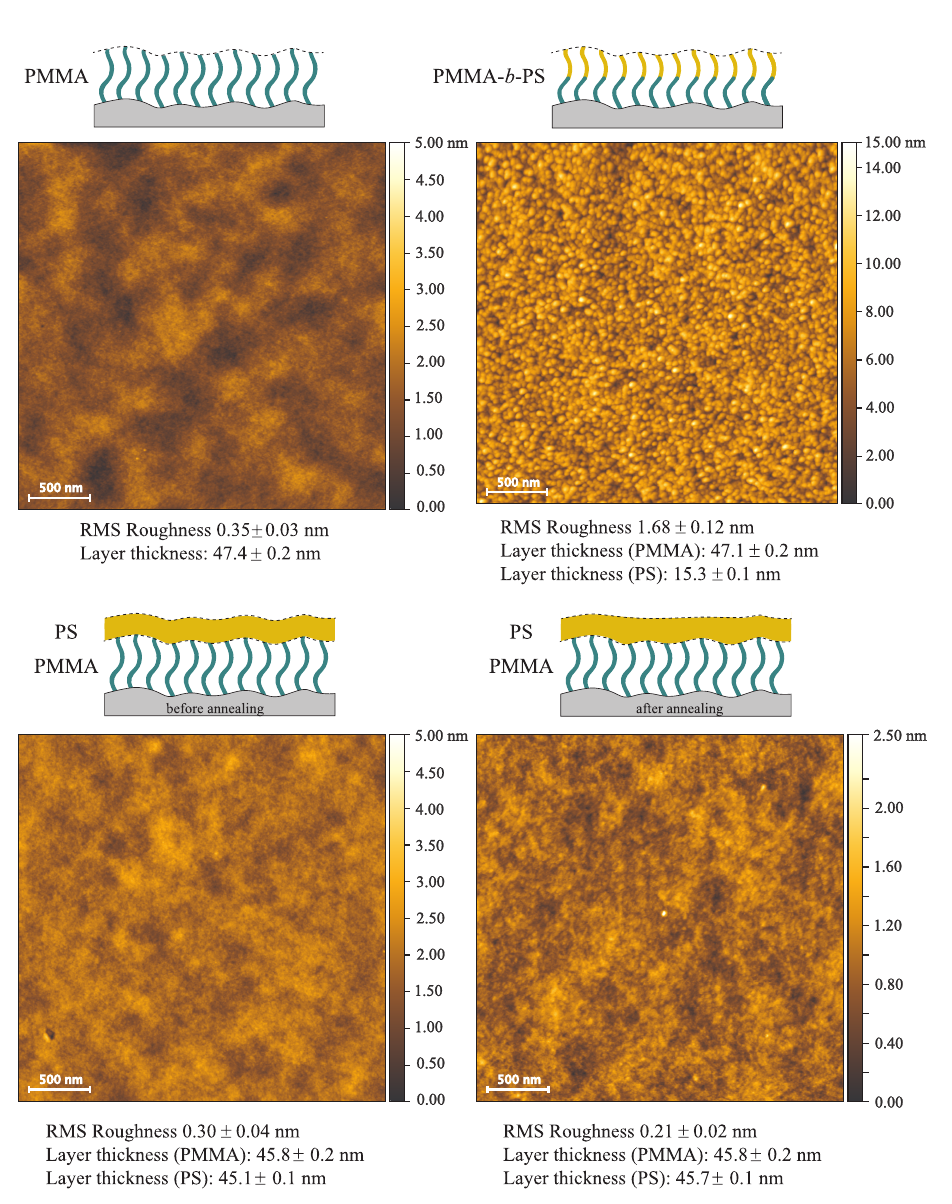
Figure 7. AFM topography images of PMMA brushes, PMMA- b -PS copolymer brushes, PMMA brushes with a PS spin-coated film without solvent vapor annealing and with annealing. Layer thicknesses were measured via ellipsometry and RMS roughnesses of topography images were determined with Gwyddion software.